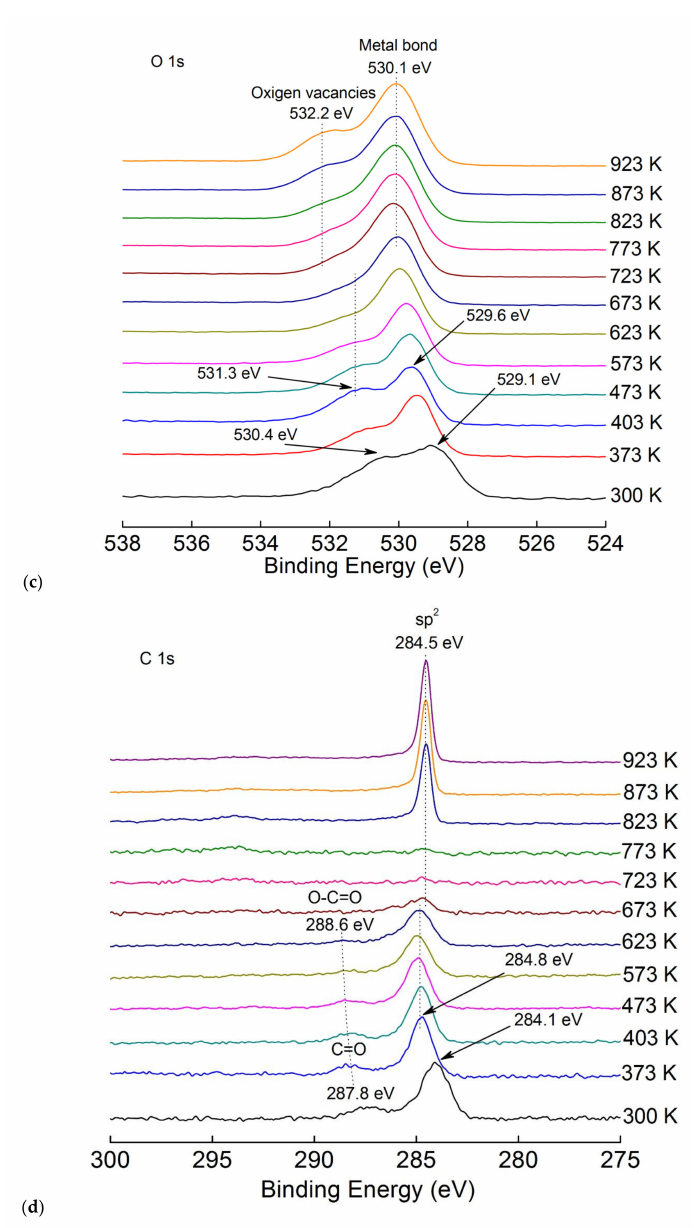
Figure 5. XPS BFO / HOPG structure: ( a ) high-resolution Fe 2p spectra; ( b ) high-resolution Bi 4f spectra; ( c ) high-resolution O 1s spectra; and ( d ) high-resolution C 1s